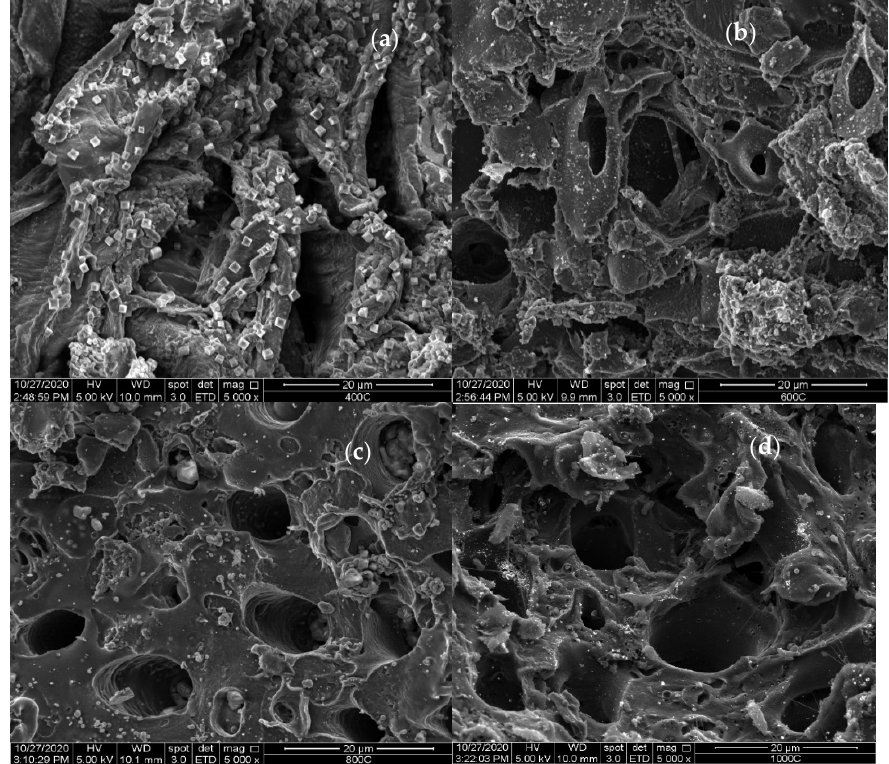
Figure 3. SEM images of the valorized date seed at ( a ) 400 °C, ( b ) 600 °C, ( c ) 800 °C, and ( d ) 1000 °C.